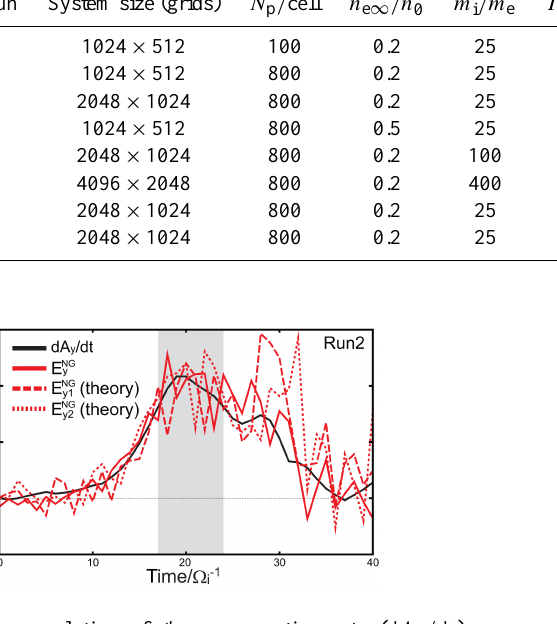
√ 2 m e T e xx = = U (cid:48) e x and E NG e y 2 y 1